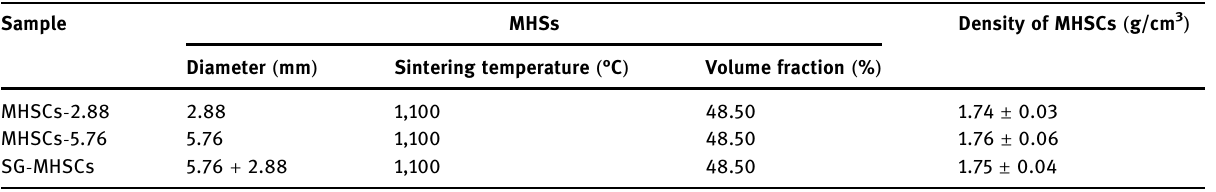
Table 2: Density of the MHSCs